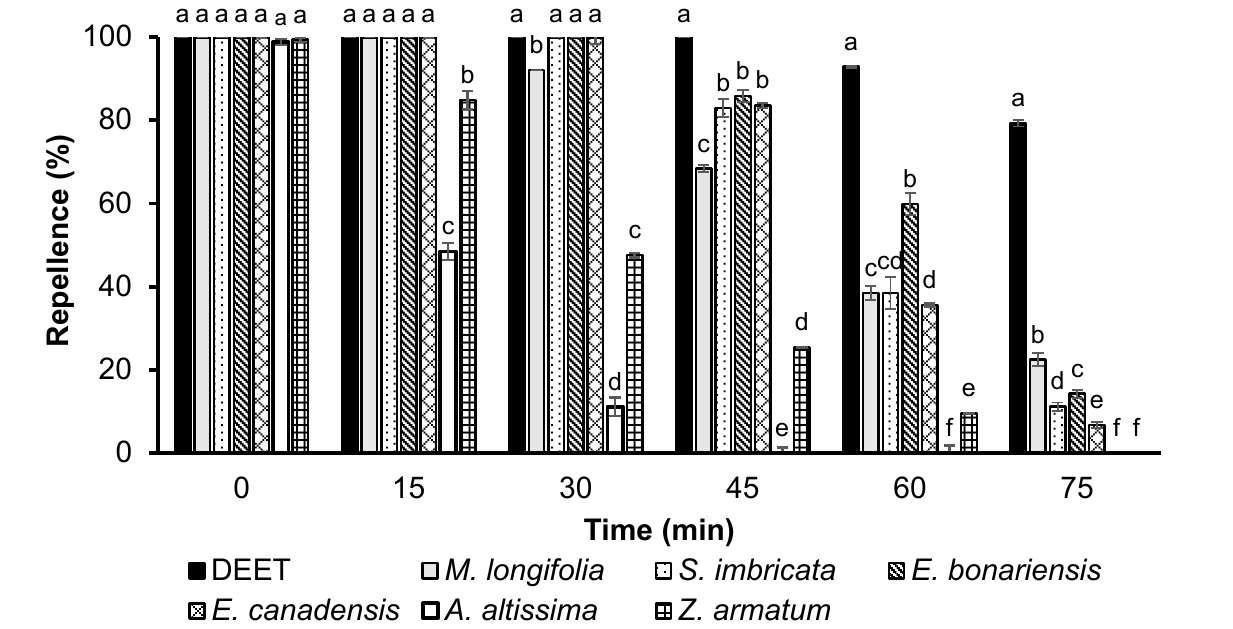
Figure 4. Time-based repellency of DEET and essential oils at a dose of 330 µ g/cm 2 against Ae. aegypti . Bars having different letters depict significant differences ( p < 0.05) among the repellency of different tested substances at different time periods of post-treatment that were compared for each period independently by ANOVA post hoc Tukey test. Error bars denote the standard error (n = 5).